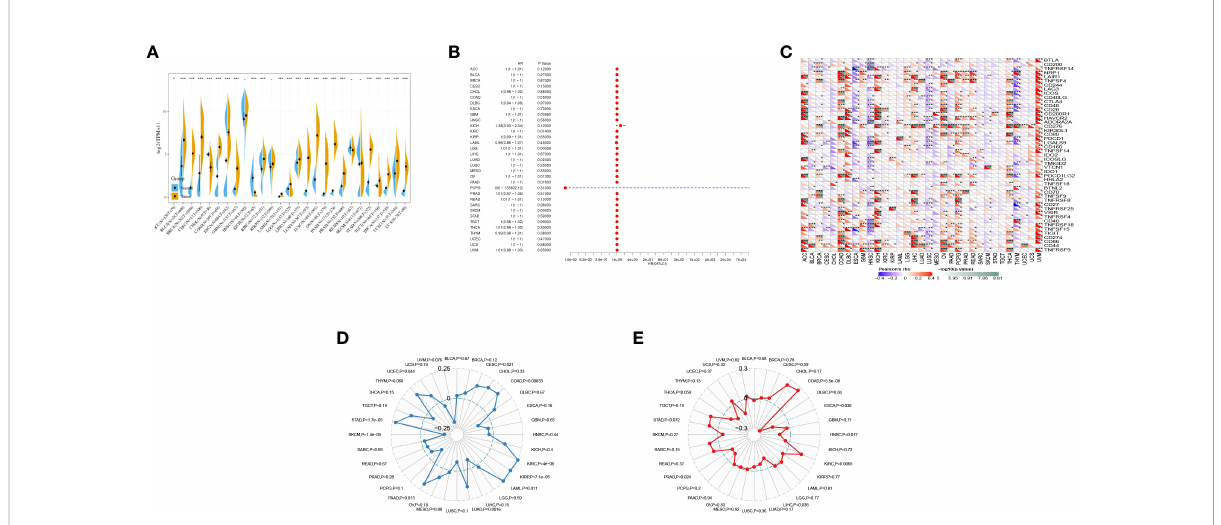
FIGURE 7 Pan-cancer analysis of GJB2 in multiple tumors. (A) Expression of GJB2 in multiple tumors; (B) prognostic analysis of GJB2 in multiple tumors; (C) correlation of GJB2 with immune checkpoints in multiple tumors; (D) correlation of GJB2 with immune mutation load in multiple tumors; (E) correlation of GJB2 with microsatellites in multiple tumors. *P<0.05,